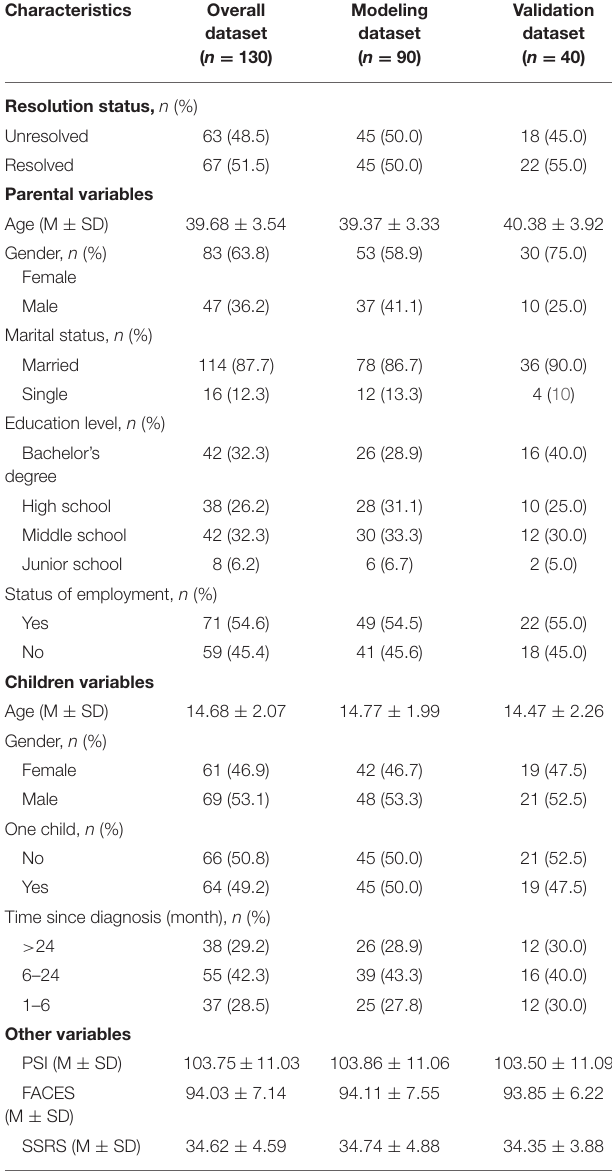
TABLE 1 | Characteristics of parents and adolescents in the modeling, validation, and overall